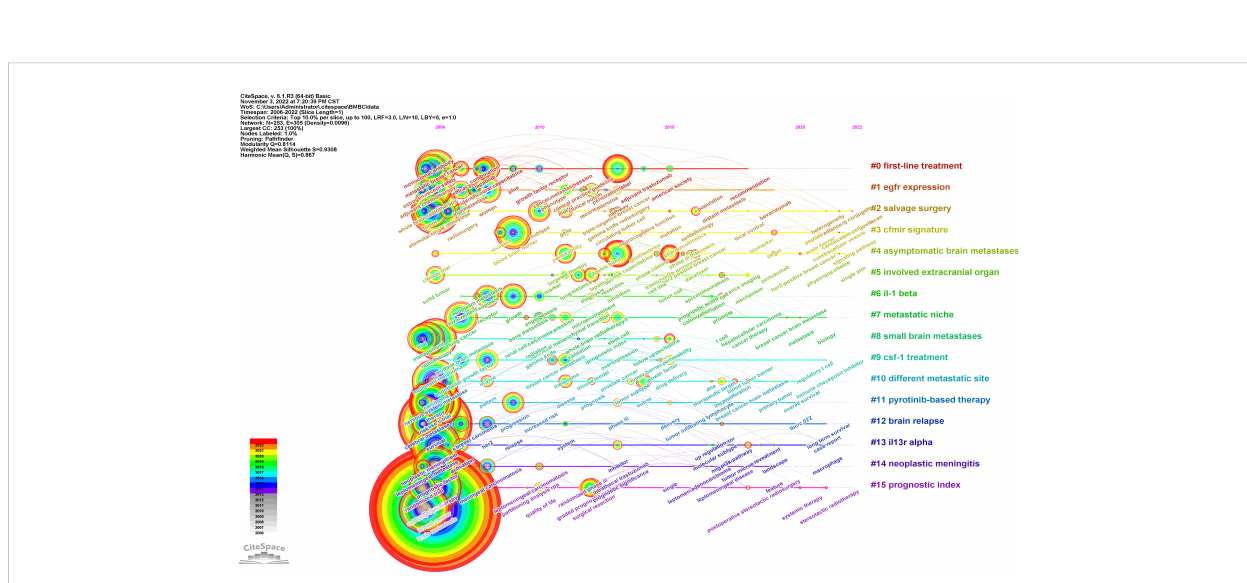
FIGURE 8 Cluster timeline of keywords of breast cancer brain metastasis. Each tree-ring node represents a keyword. The size of the node is proportional to the time of the occurrence of the keyword. The color of the tree-ring node represents the occurrence history of the keyword. The label of clusters was produced by LLR analysis, and the colors represent different